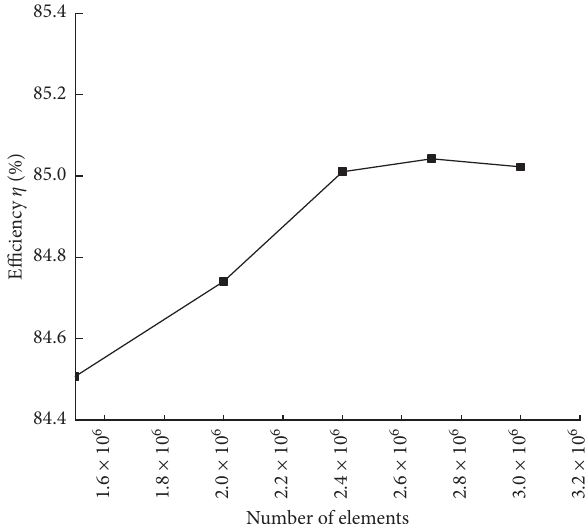
Figure 2: Grid independence